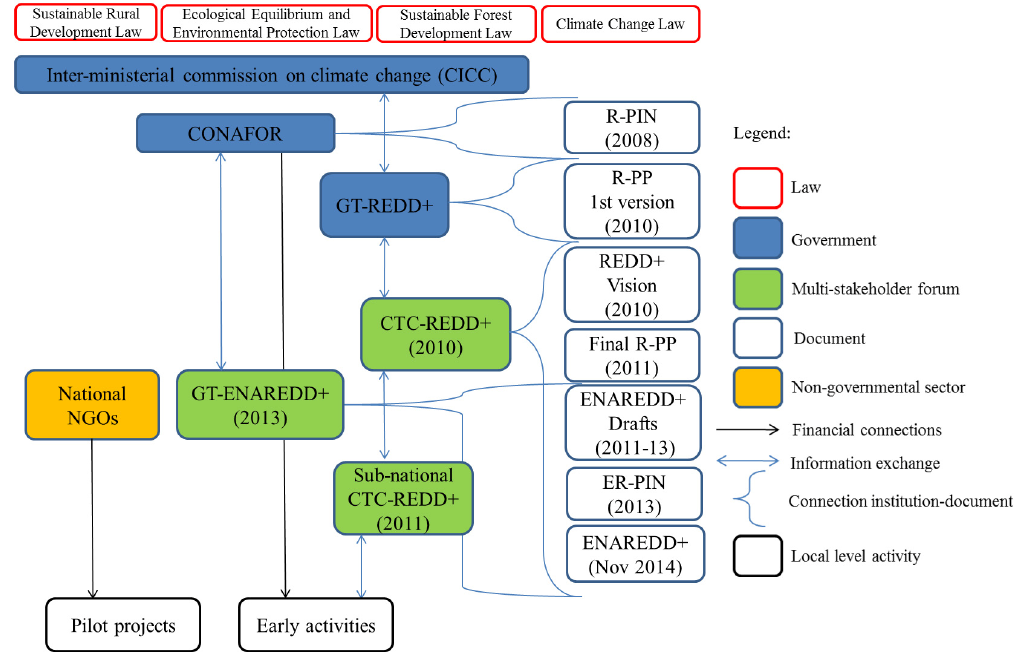
Figure 1. Main laws, documents, and activities in Mexico’s REDD+ readiness governance system and their authoring and/or implementing actors and consultative forums. Source: own elaboration. REDD+, Reducing Emissions from Deforestation and forest Degradation; ENAREDD+, Mexico’s national REDD+ strategy in Spanish; CONAFOR, National Forest Commission; R-PIN, Readiness Plan Information Note; R-PP, Readiness Preparation Proposal; ER-PIN, Mexico’s Emission Reductions Initiative Idea Note; CTC-REDD+, Technical Advisory Committee for REDD+; GT-REDD+, Working Group for REDD+; GT-ENAREDD+, Working Group on ENAREDD+; NGOs, non-governmental